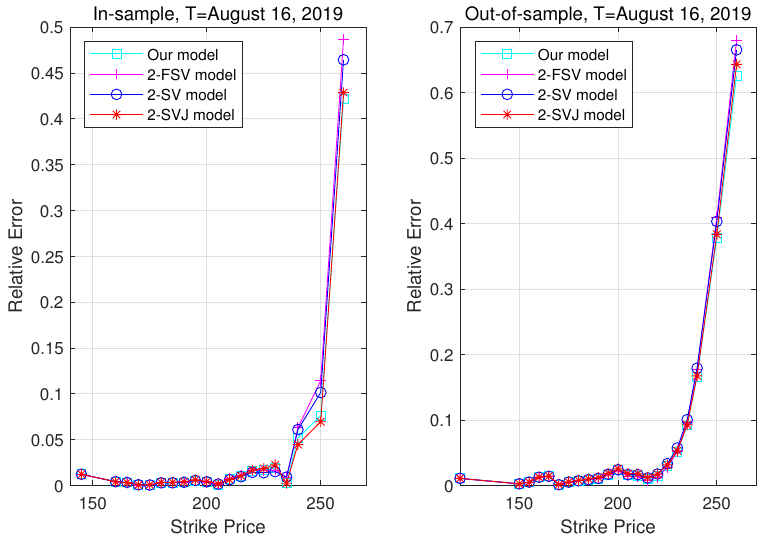
Figure 7. The comparison of predicted prices of four model specifications and market prices on 9 May 2019, with maturity T = 16 August